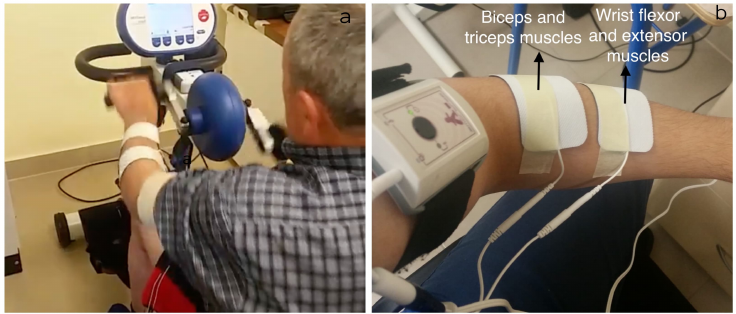
Figure 1. ( a ) Motorized upper limb cycle ergometer (MOTOMED Viva2 REck, Reck, Baden- Wurttemberg, Germany), and ( b ) Placement of electrodes on the biceps, triceps, wrist flexion and extension muscles.